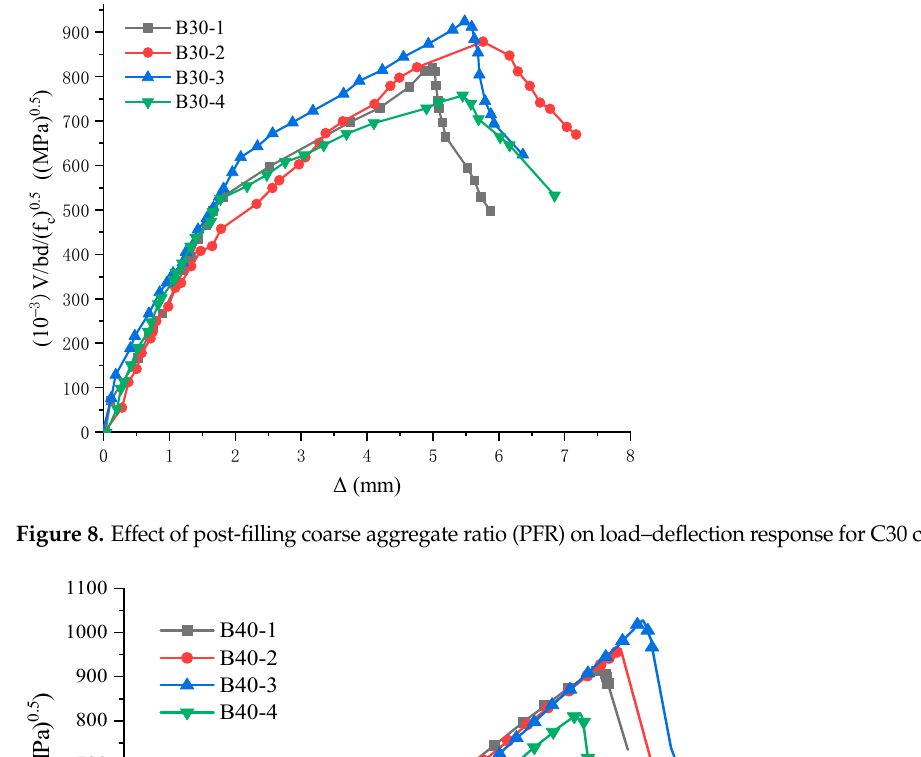
Figure 9. Effect of PFR on load–deflection response for C40 concrete.